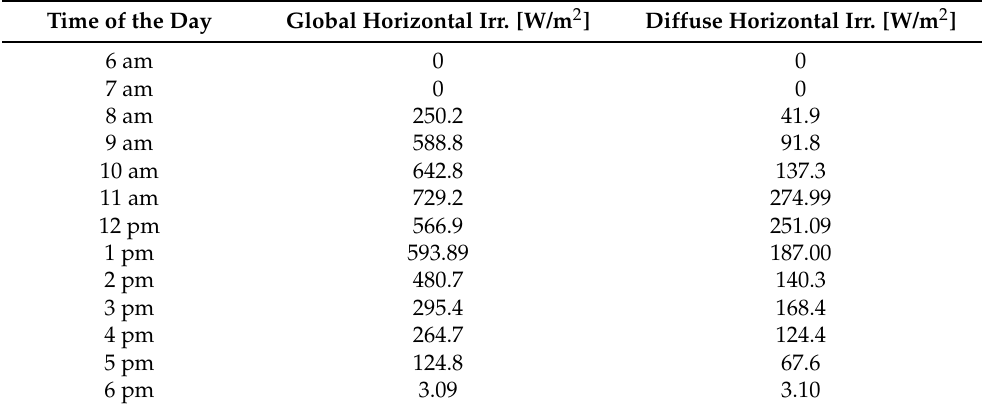
Table 3. Source irradiance data used in PVSyst and the model simulation (Feb 2017). Time of the Day Global Horizontal Irr. [W/m 2 ] Diffuse Horizontal Irr. [W/m 2 ] 6 am